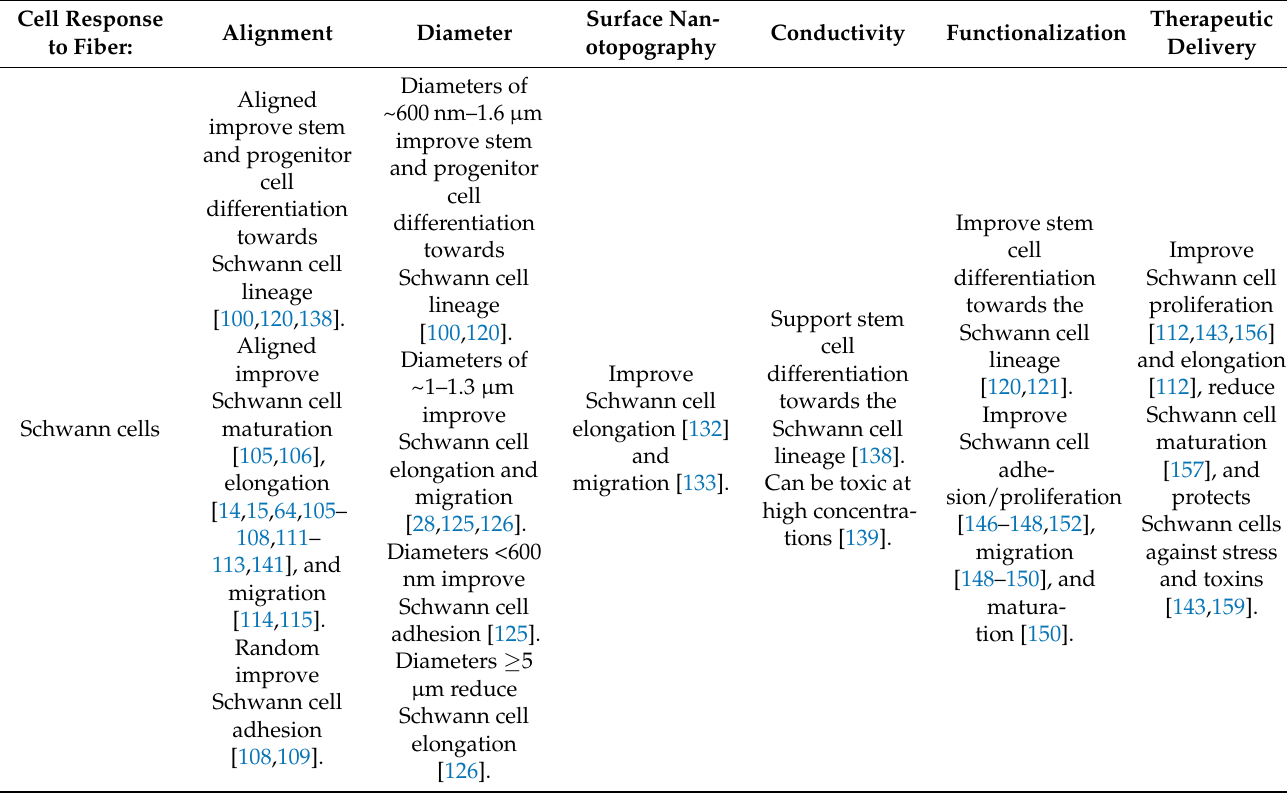
Table 2. Summary of Schwann cell response to various electrospun fiber properties in vitro. Cell